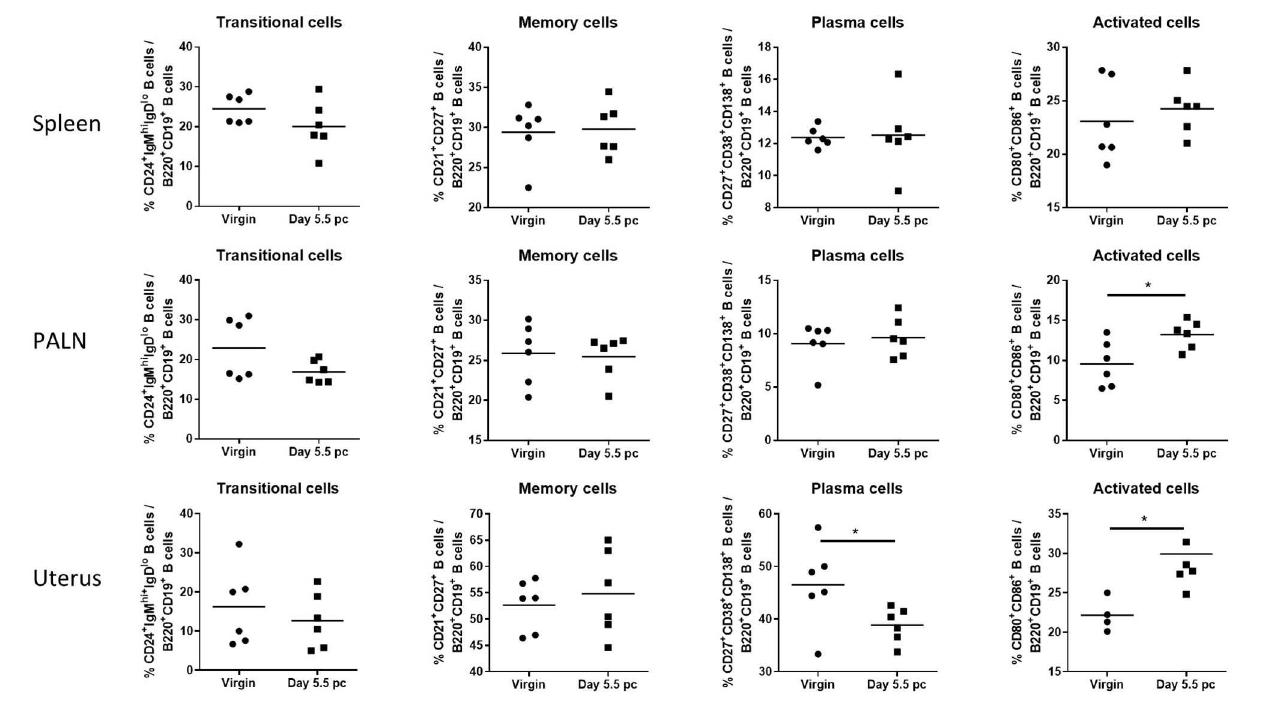
FIGURE 2 | B cell subsets in the para-aortic lymph nodes and uterus are altered post-implantation. Percentages of transitional or mature naive B cells (CD24 + IgM hi IgD lo ), memory B cells (CD21 + CD27 + ), plasma B cells (CD27 + CD38 + CD138 + ), and activated B cells expressing co-stimulatory molecules (CD80 + CD86 + ) were investigated in the spleen, para-aortic (uterus draining) lymph nodes, and uterus of virgin and pregnant mice at day 5.5pc ( n = 6, p -values calculated by unpaired t -test). * p ≤ 0.05.